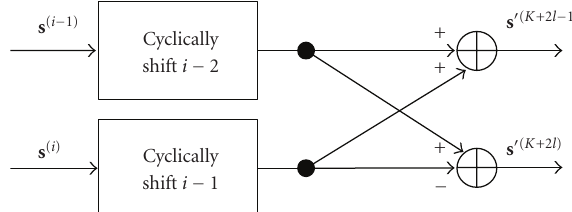
Figure 2: Algorithm of cyclically shifting for generating new se- quences.